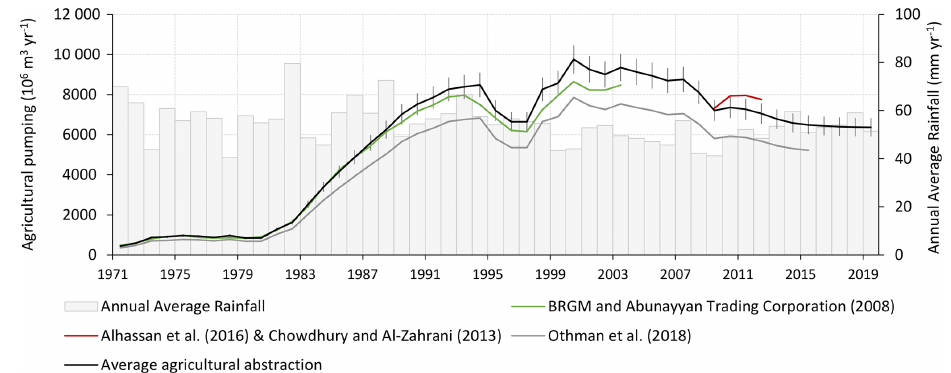
Figure 2. Annual average rainfall (Climatic Research Unit; mmyr − 1 ) of the Saq–Ram Aquifer System and agricultural withdrawal (from different sources represented by coloured lines; 10 6 m 3 yr − 1 ) of its Saudi part (except for Othman et al.’s, 2018 data corresponding to the Al-Qassim, Ha’il, and Al Jawf regions of Saudi Arabia). Most of these previously published data come from governmental entities, without providing any associated